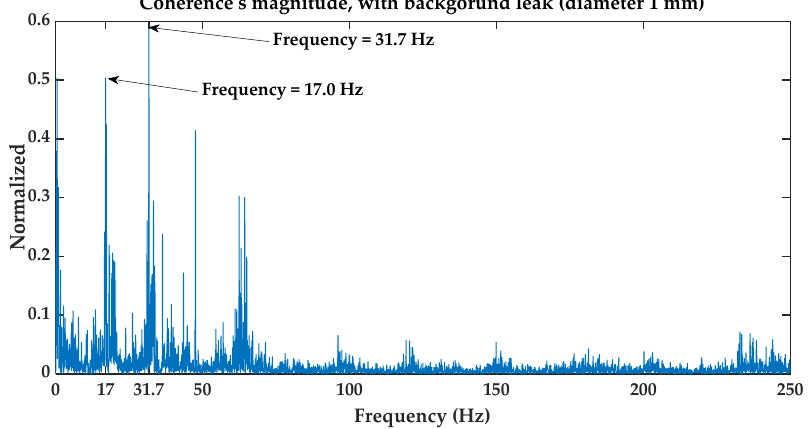
Figure 11. Coherence’s magnitude, with background leak ( 1 mm in diameter) and flow rate 33.7 mL/s .